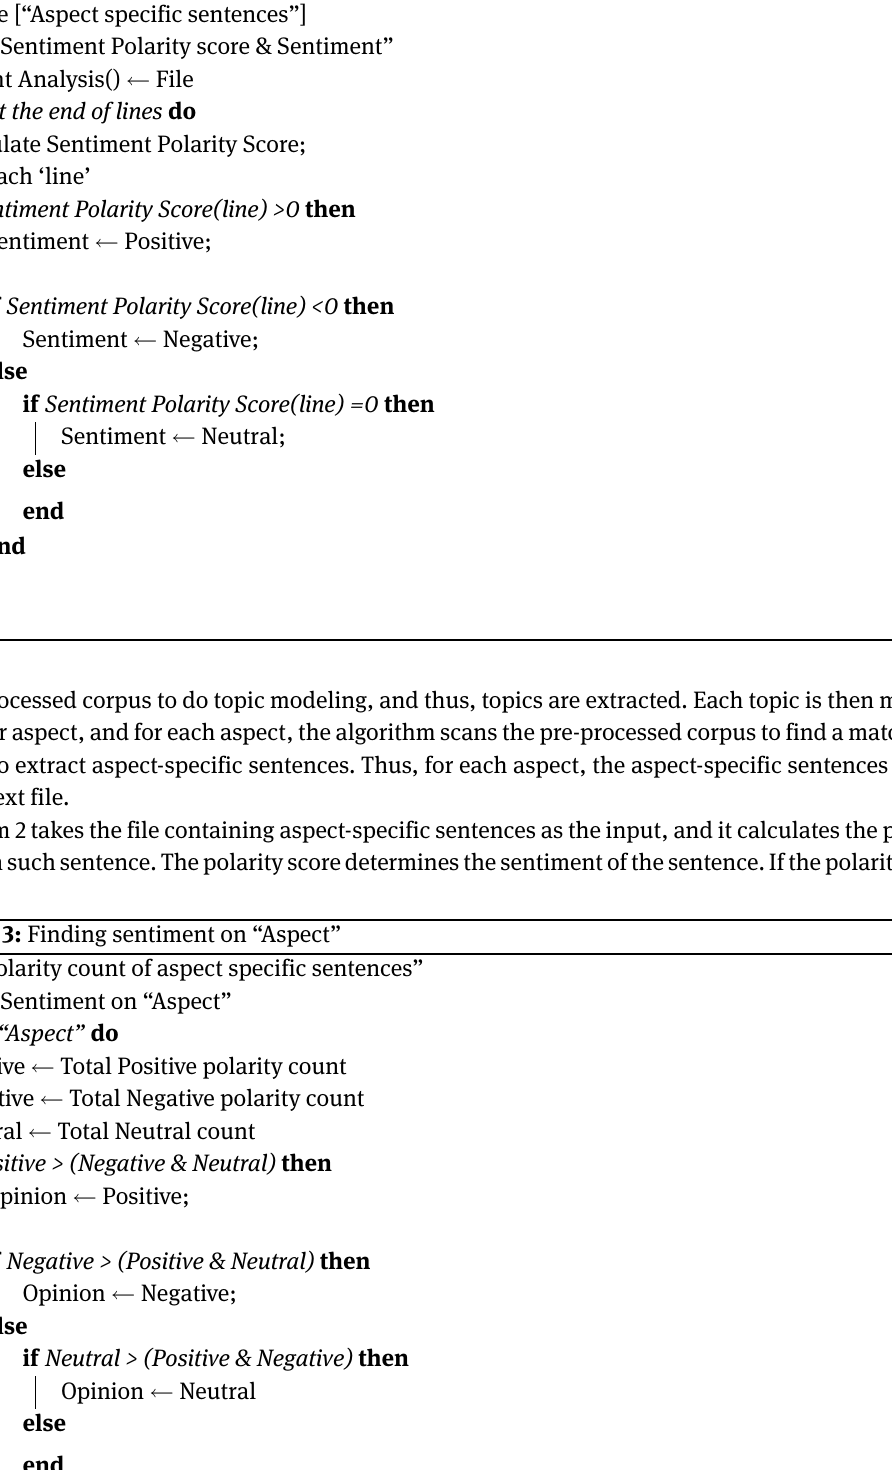
Algorithm 2: Aspect specific Sentiment Analysis Data: File [“Aspect specific sentences”]